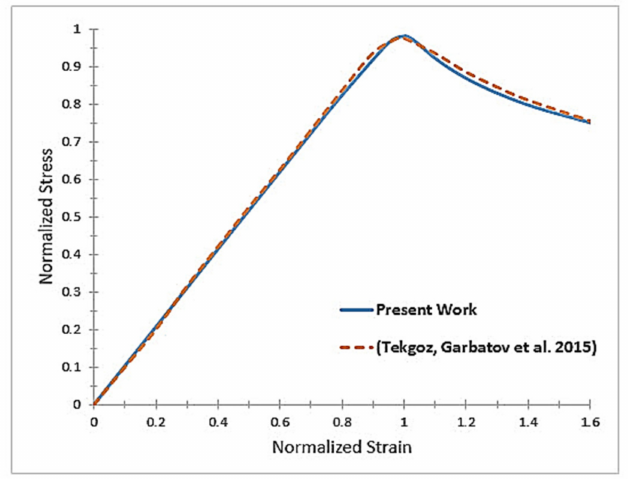
Figure 9. Load-shortening curve without welding